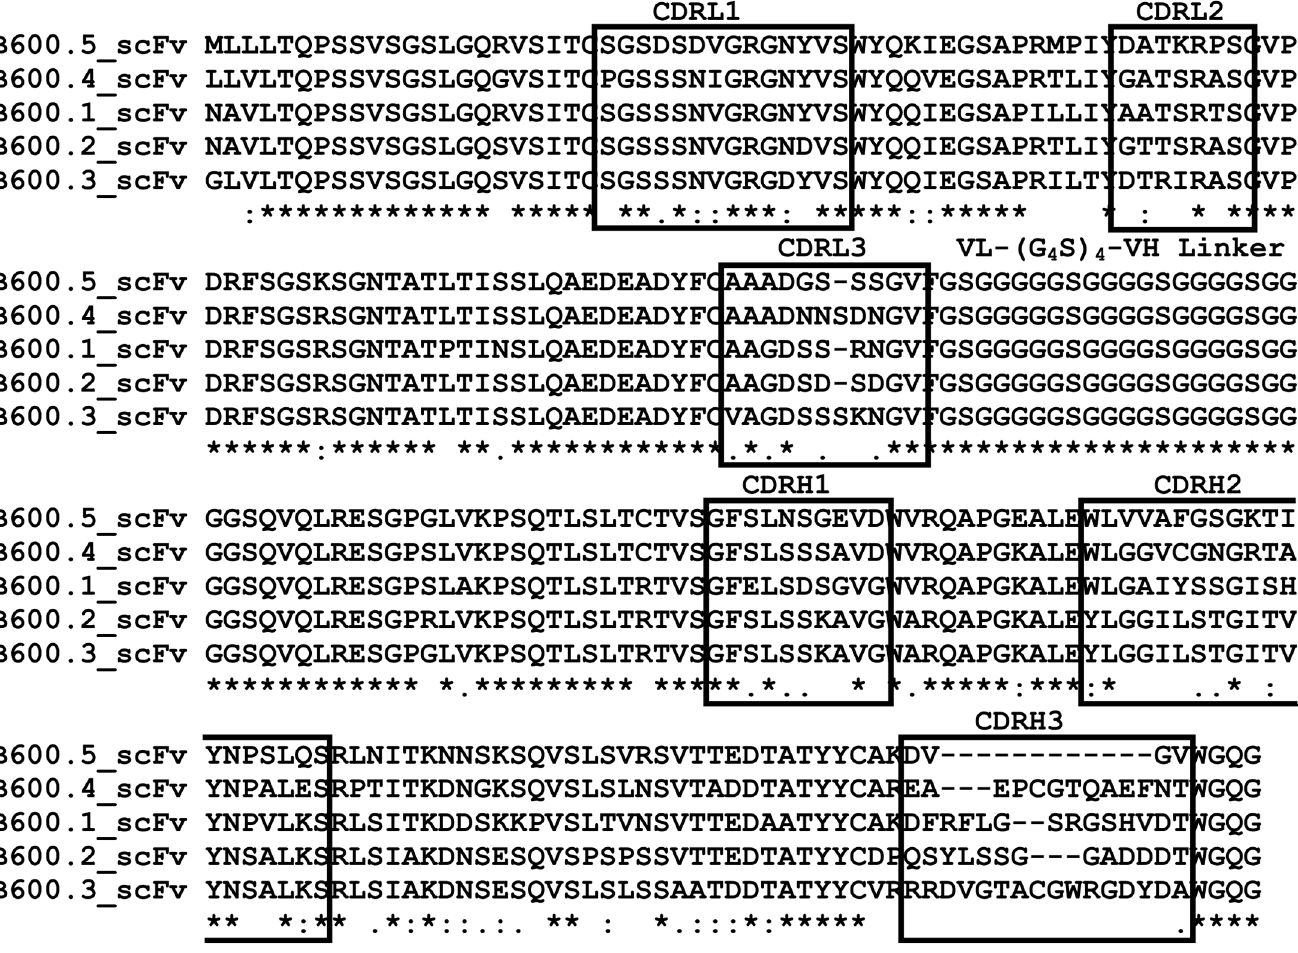
Fig 4. Clustal Omega alignment of soluble single-chain antibody Fv domain-alkaline phosphatase (scFv-AP) antibody sequences. Complementarity determining regions (CDR) regions of variable light (CDRL1-3) and variable heavy (CDRH1-3) chains are indicated in boxes. Respective VL and VH regions show similarity within the framework regions and distinct differences within CDR regions, particularly within CDRH3. ( * ) indicates a fully conserved residue, (:) a strongly similar and (.) a weakly similar residue.